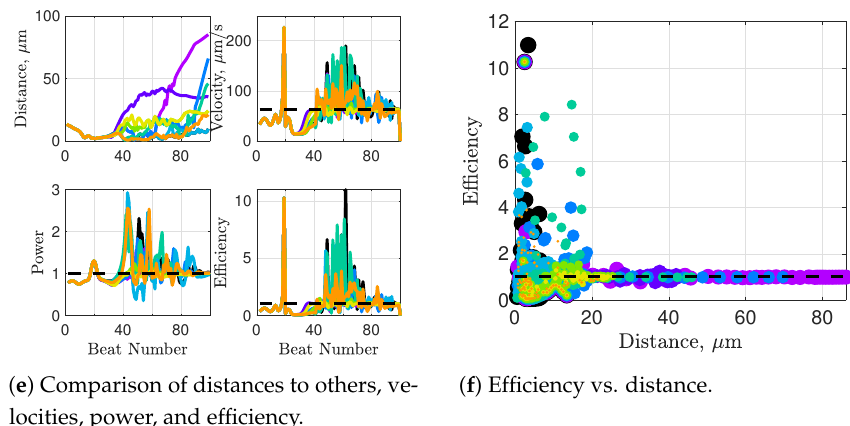
Figure A1. Simulation results for a cylindrical configuration of 9 flagella with no repulsion forces present. Distance refers to minimal distance from flagellum to any neighbors. Color of curves indicates data for flagellum of matching color. Units in panels ( a – d ) are in µ m. See Supplemental Material Movie